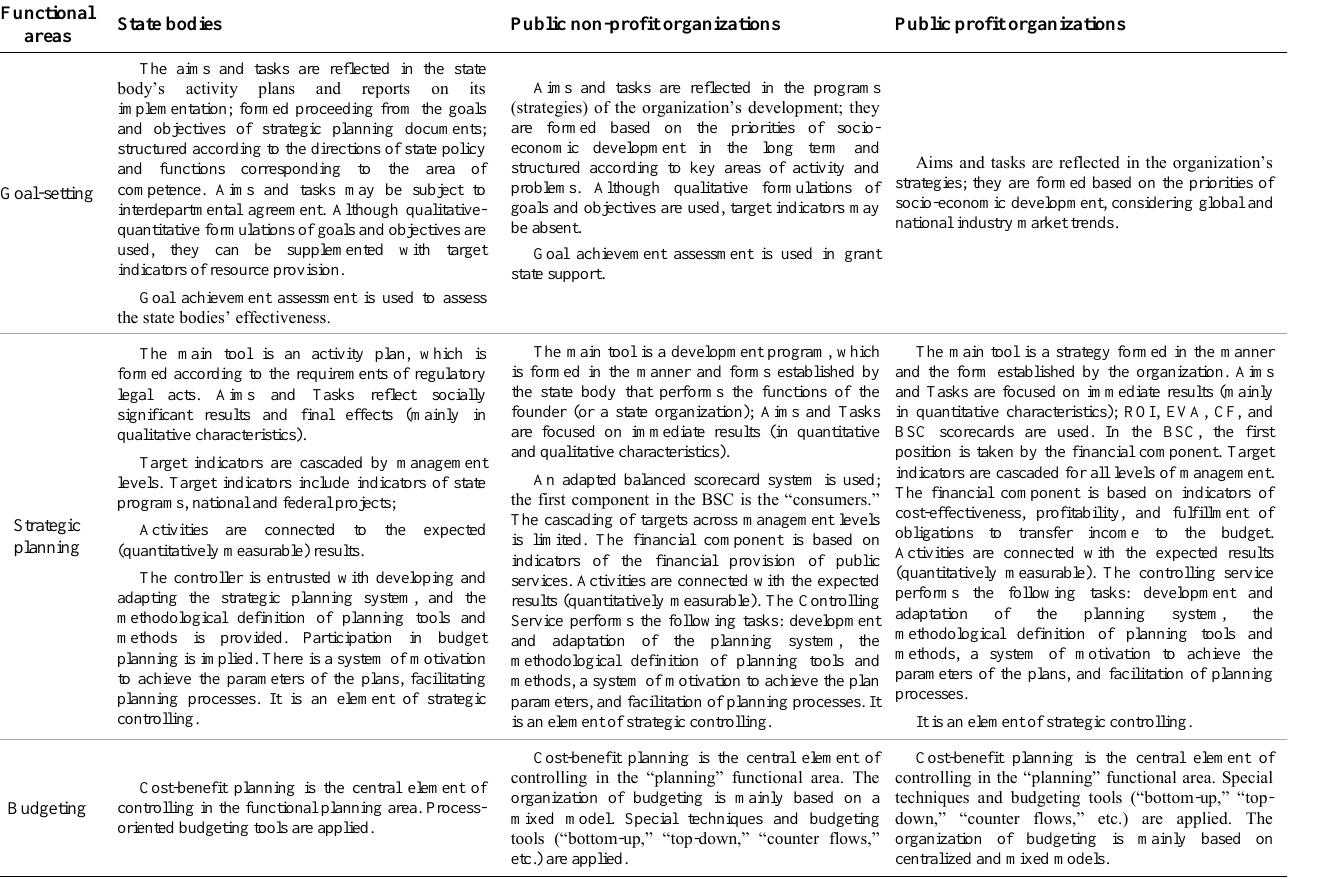
Table 12. Performance comparison of controlling in state bodies and organizations (Compiled by the